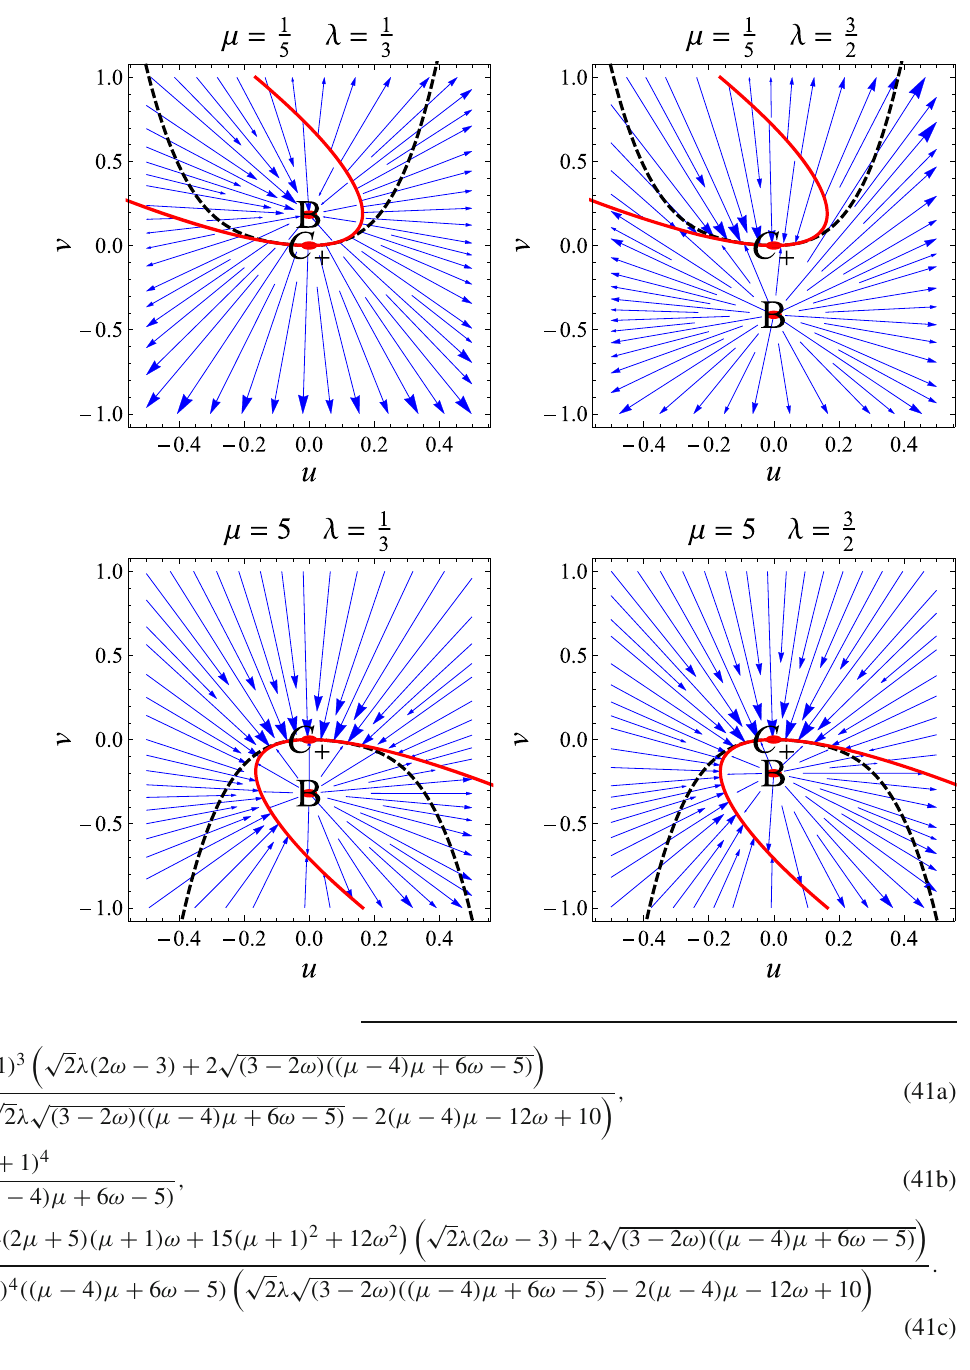
In Fig. 4 we show the qualitative evolution ( u , v) given by (38) for ω = 0. The solid red lines in each plot denote the implicit function √ 6 x ( u ) + y ( u , v) 2 + 1 = 0, with x ( u ) and y ( u , v) defined by (37) for ω = 0, whereas the dashed black lines shown in each plot represent the approximated center manifold of C + . Observe the accuracy for small u